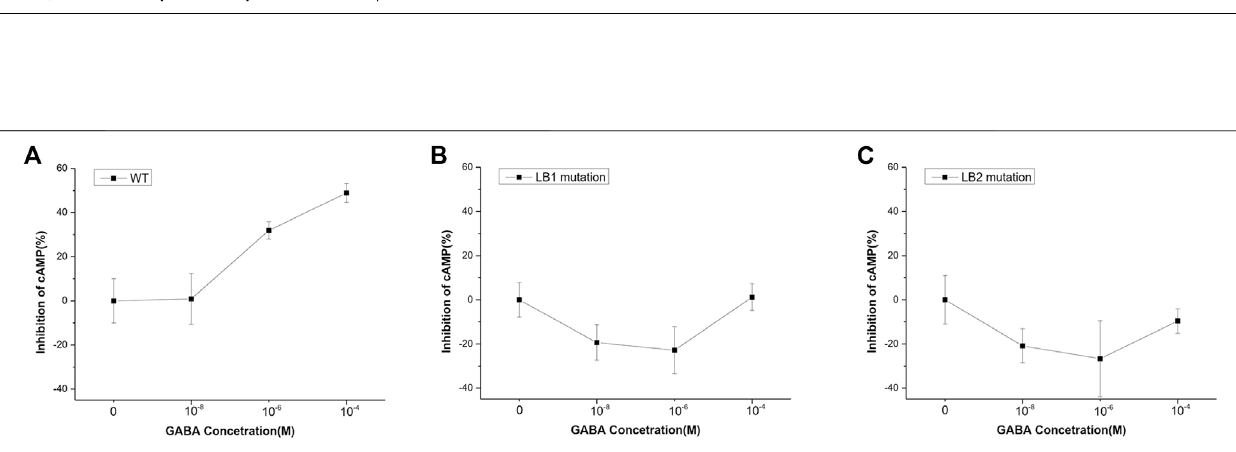
Frontiers in Chemistry |